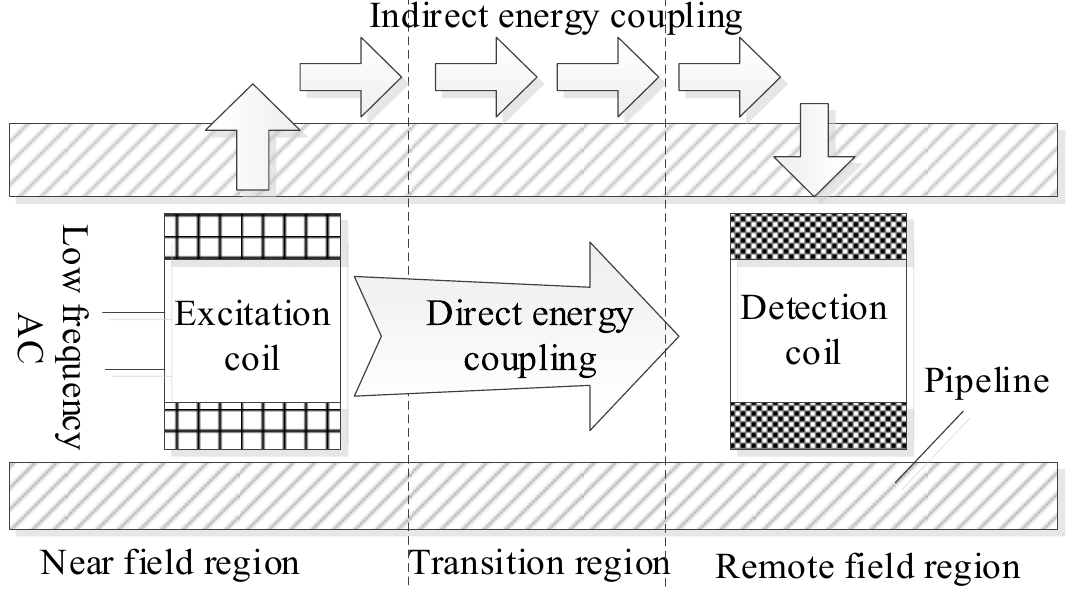
Figure 2. Schematic diagram of pipeline remote field eddy current testing.